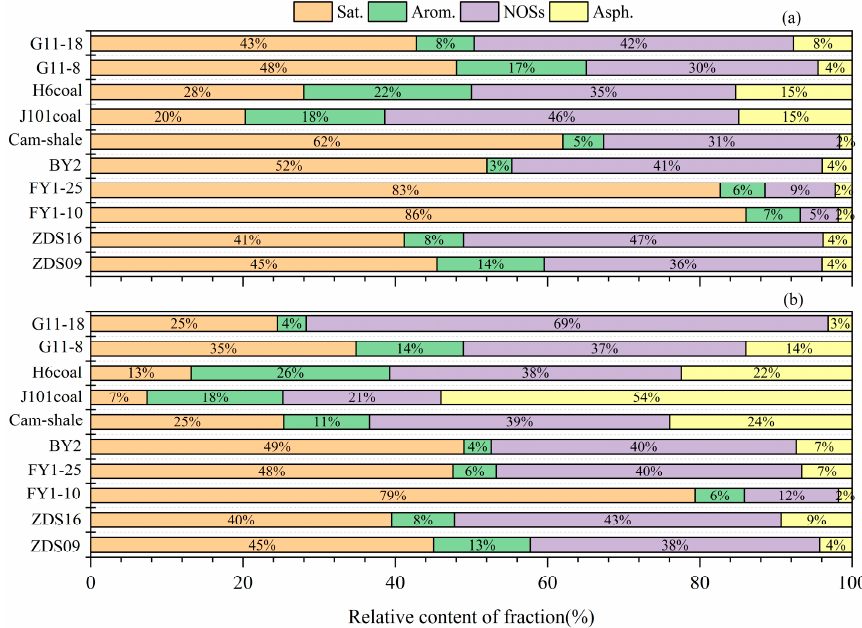
Figure 2. The relative contents of fractions with different solvent: ( a ) TCM, ( b ) DCM: MeOH.